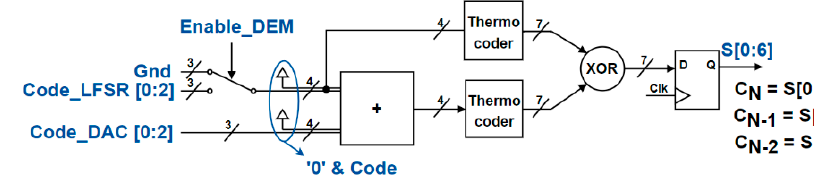
Figure 11. A 3-bit DEM architecture.